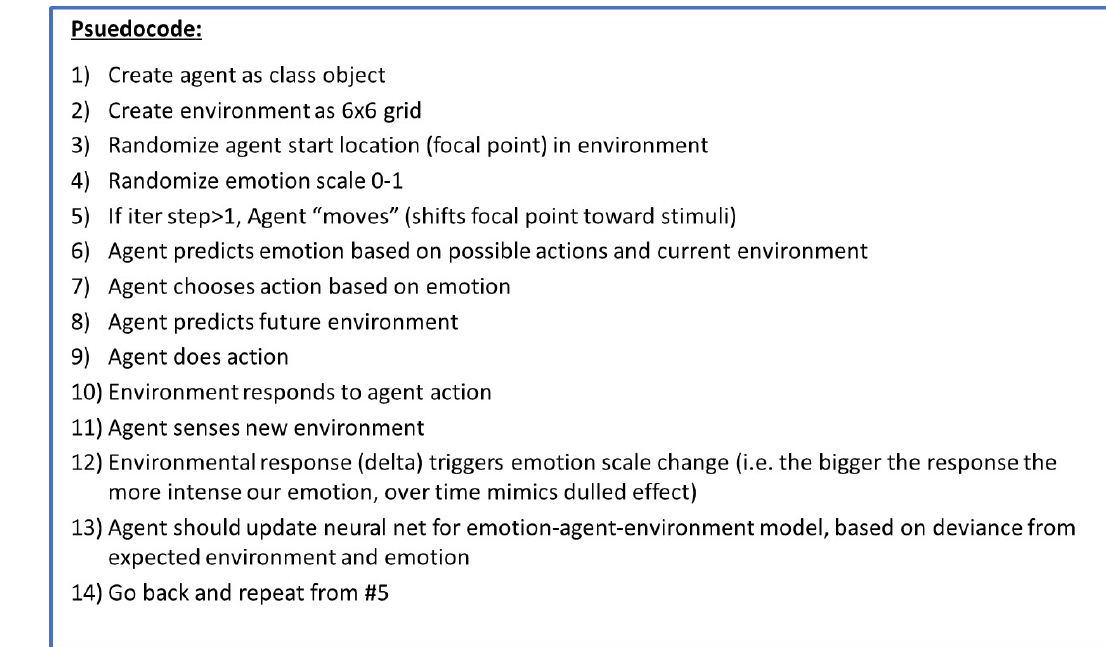
Figure 3. MLP neural network schematic. Optional LSTM module for RNN version showed in blue dotted lines, with the input shape taking form (None, 2, 36) for the simple case of current and previous timestep.